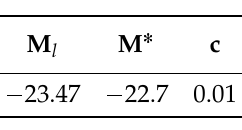
Figure 10. The luminosity function data of zCOSMOSare represented with error bars. The continuous line fit represents our gamma truncated LF (44); the chosen redshift is z in Tables 3 and 4. Table 3. Parameters of the gamma truncated LF independent of z when c